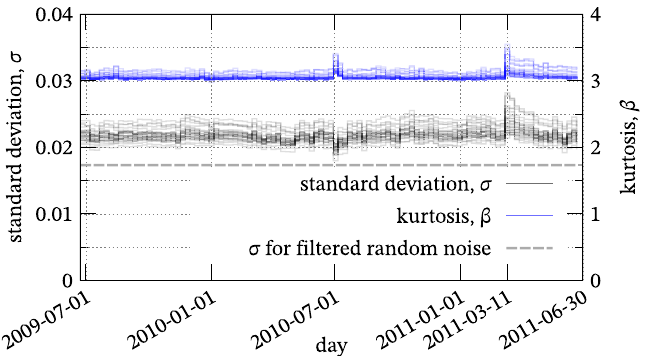
Figure 5. Temporal variation of the standard deviation and kurtosis of the empirical distribution of